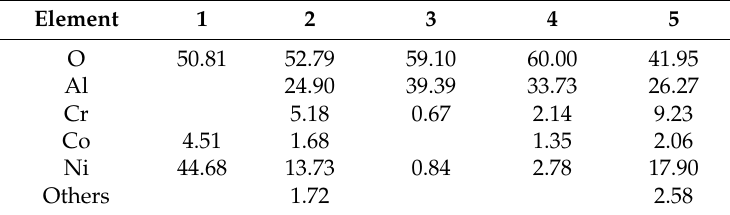
Table 2. The atomic percentages (at.%) of elements at di ff erent locations measured by EDS in Figure 3.